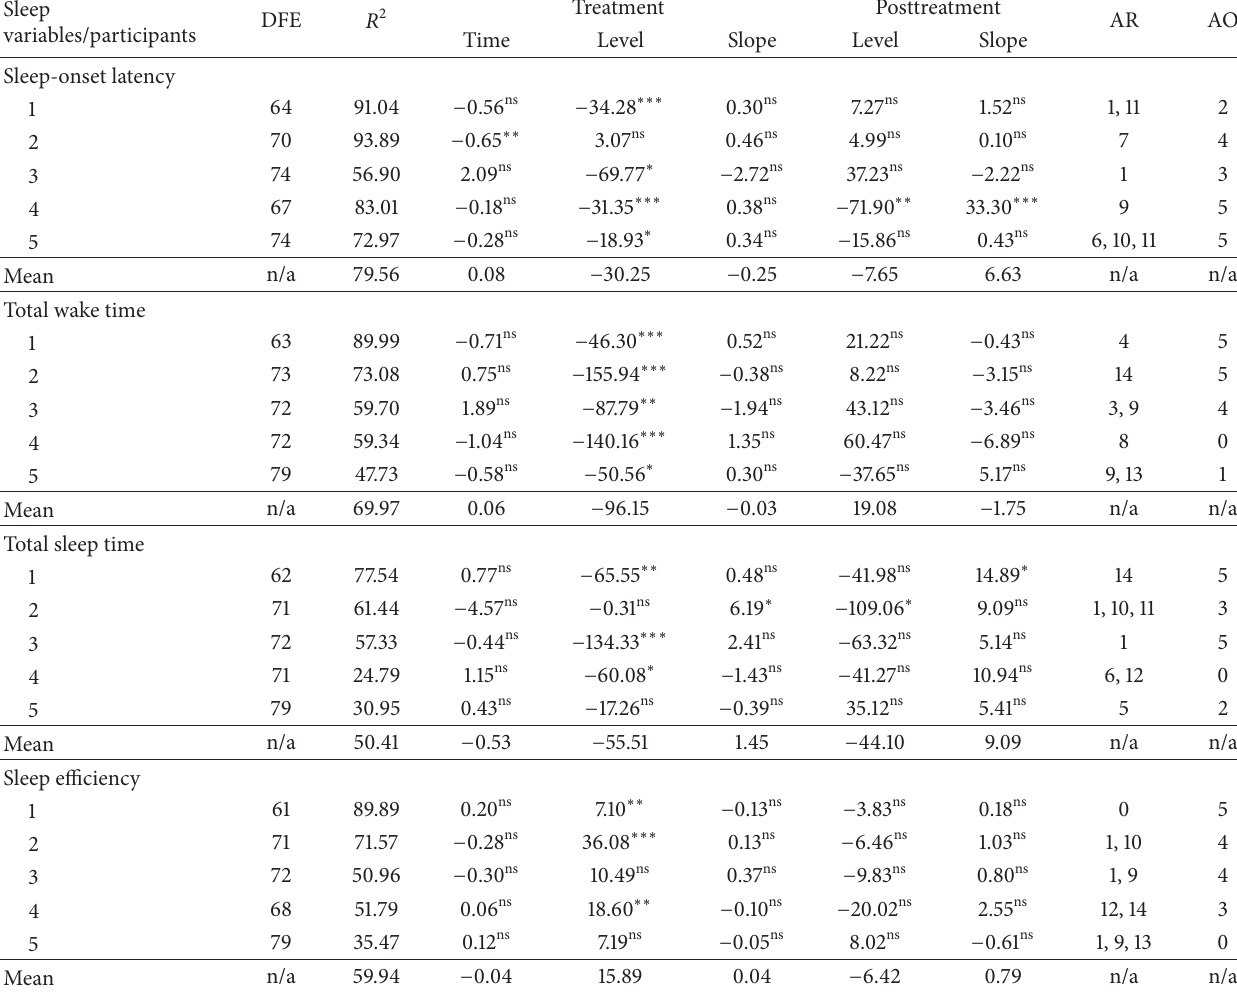
Table 2: Nature and direction of change between baseline, treatment, and post-treatment for each sleep variable and participant. Sleep variables/participants